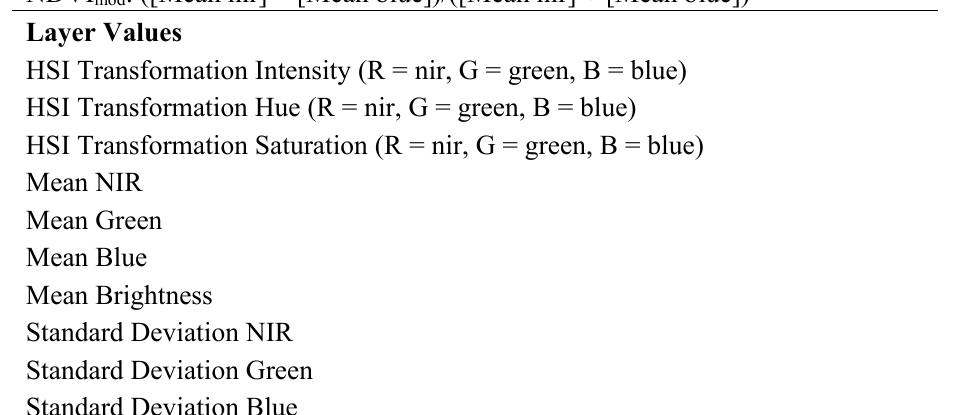
Table 2. Object features used during object-based image classification with